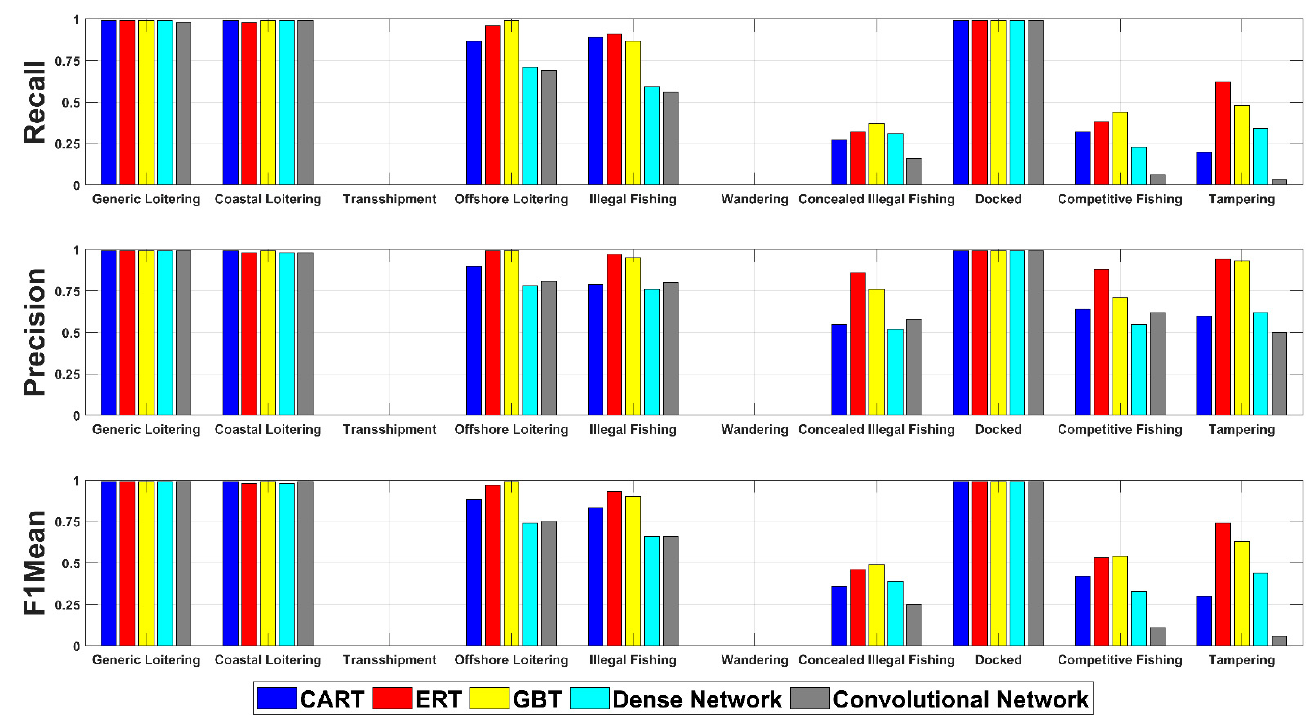
Figure 6. Results for all techniques tested for the behavioral classifier. Recall, precision, and F1Mean scores are shown for all behaviors labeled in the Ship Log. No algorithm was able to detect the rare transshipment and wandering behaviors.